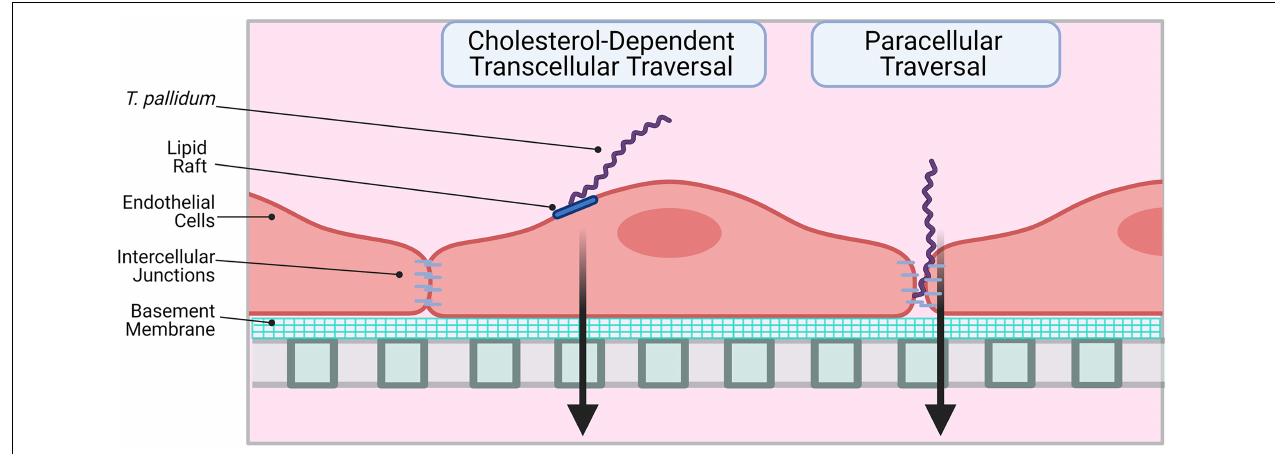
FIGURE 10 | Proposed model: two routes for T. pallidum transendothelial migration. Left: T. pallidum coordinates transcellular traversal by engaging host receptors in lipid rafts (LamR) and inducing uptake and transport across the endothelium in a cholesterol-dependent manner. Right: T. pallidum adheres to endothelial cells at sites of intercellular junctions and disrupts VE-cadherin to open a paracellular traversal route. Intercellular junctions are re-formed after traversal to prevent vascular leakage. Figure created in